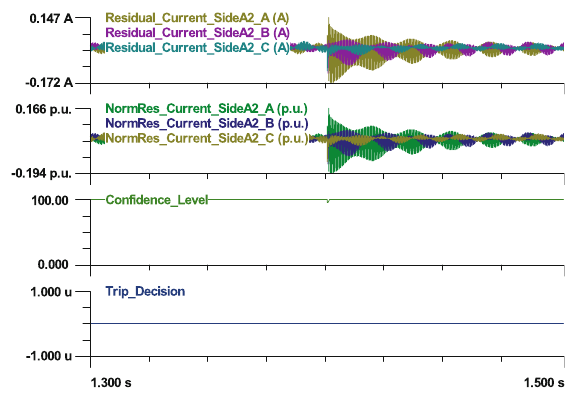
Fig. 15 EBP relay performance of event 3: external bolted fault, grid-connected